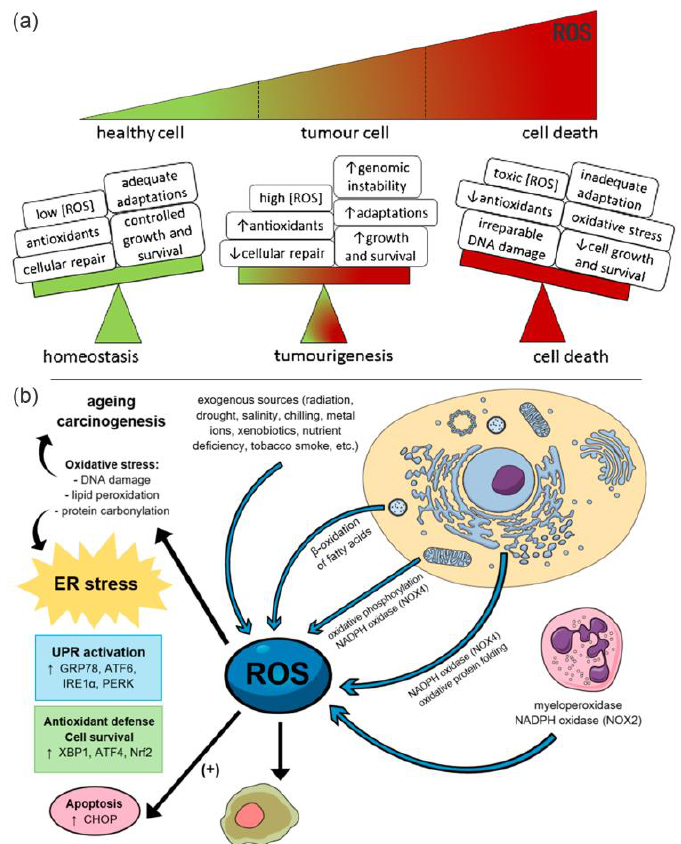
Figure 1. ( a ) Effect of ROS level on cells. Reproduced with permission [18]. Copyright 2018, Elsevier Ltd. ( b ) ROS−induced damage to the cells. The arrows indicate the sources of ROS and their effects on cells. Reproduced with permission [19]. Copyright 2019, MDPI (Basel, Switzerland). Healthy cells can keep adequate adaptations to overcome the damaging effects of ROS. Elevated ROS levels at toxic concentrations can generate oxidative stress, resulting in irreparable damage to the cell, inadequate adaptations and eventually tumor cell